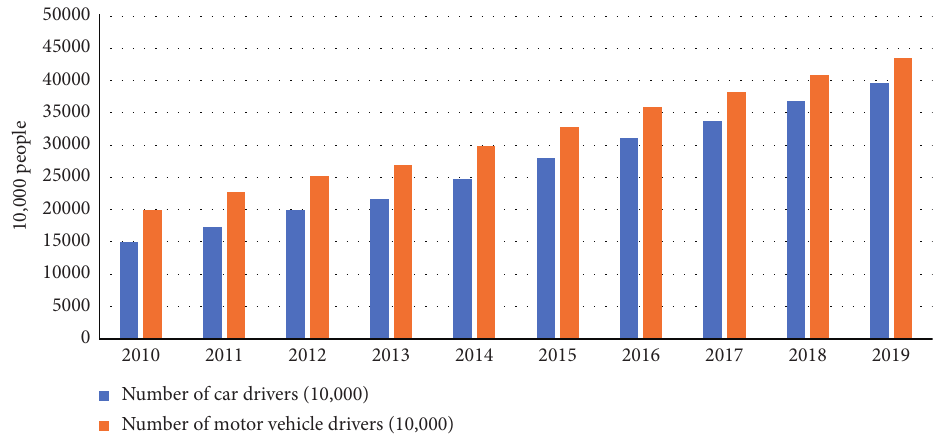
Figure 1: Driver growth trend in China in the past 10 years (data source: National Bureau of Statistics, 2019,